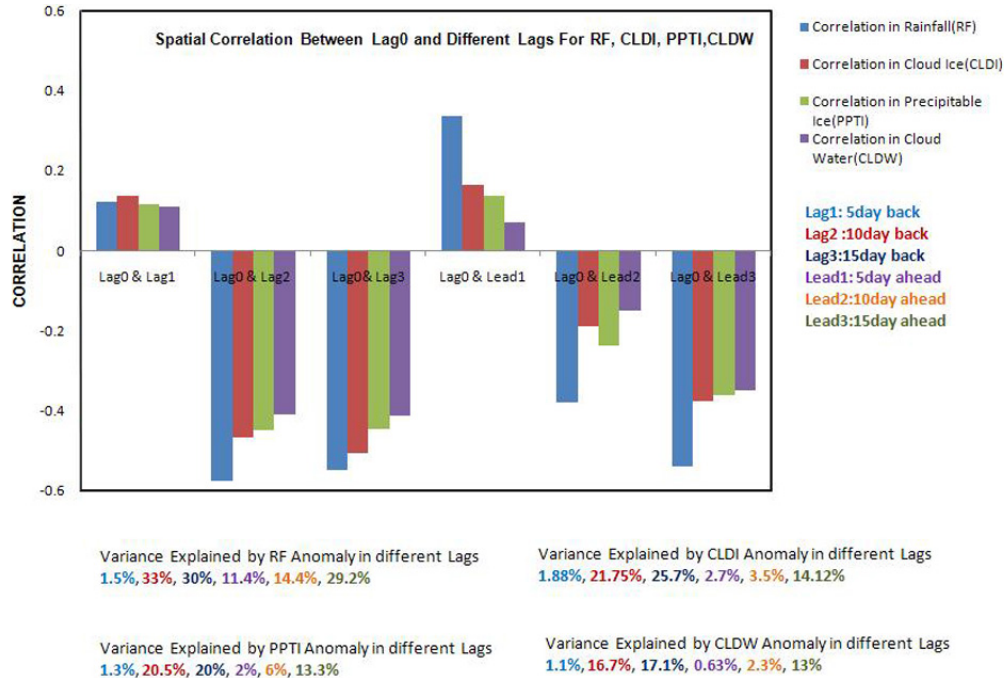
Fig. 18. Spatial correlation between lag 0 and lag 1, lag 2, lag 3, lead 1, lead 2 and lead 3 for each hydrometeor type and rainfall and corresponding variance explained using TRMM